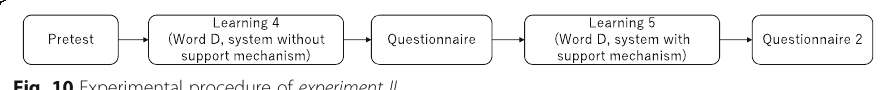
Fig. 10 Experimental procedure of experiment